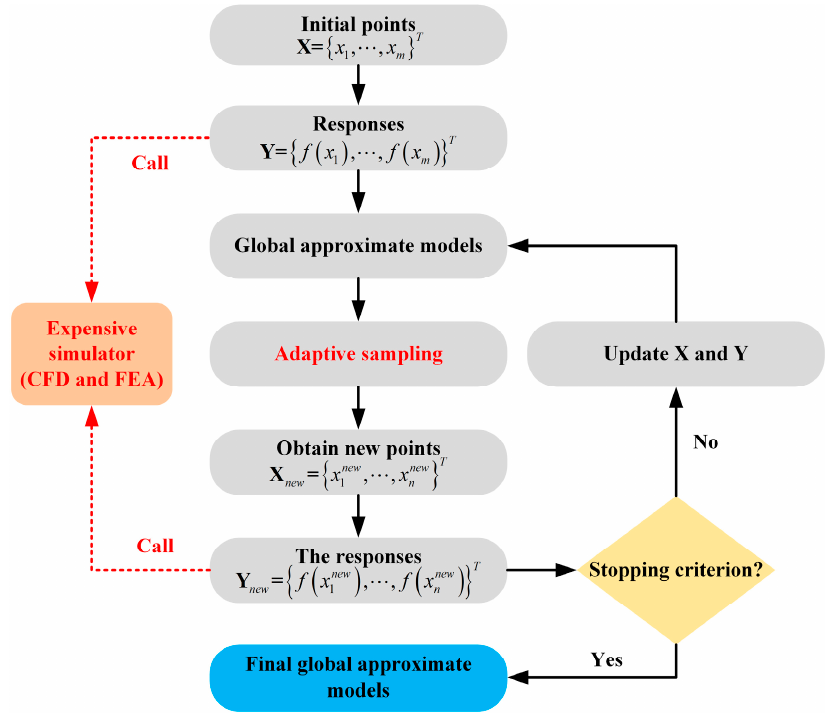
Figure 1. General flowchart of an adaptive sampling approach for global dynamical approximate models.